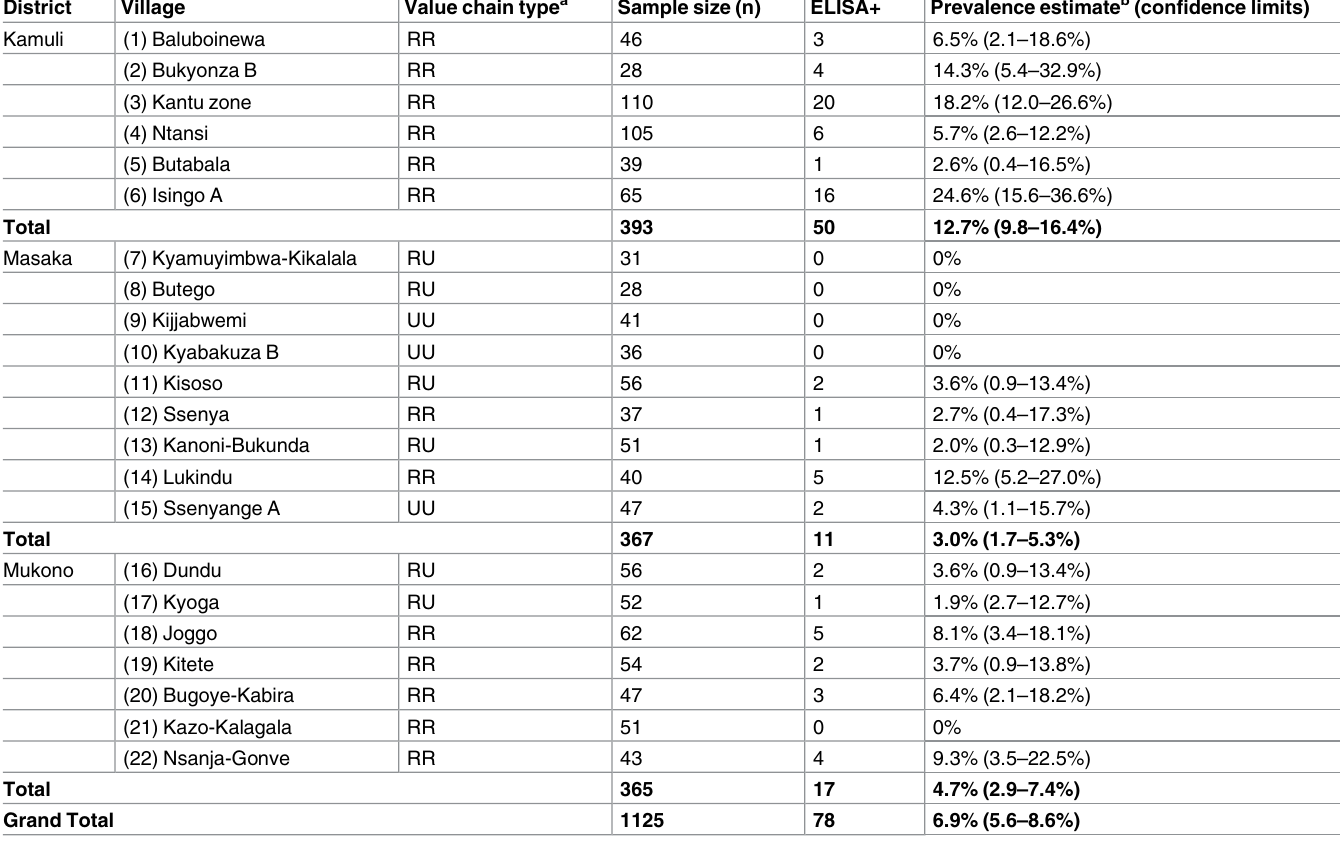
Table 1. Prevalence estimatesfor anti- Trichinella IgG (PrioCHECK ® Trichinella Ab) in three districts in Central and Eastern Uganda, sampled between April and July 2013. District Village Value chain type a Sample size (n) ELISA+ Prevalence estimate b (confidence